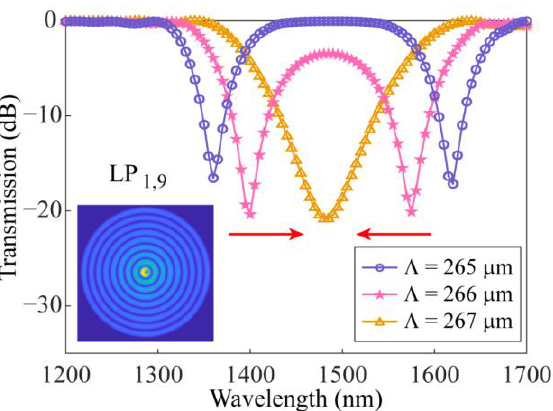
Figure 5. The simulated transmission spectra of the SMF-HLPGs with different grating periods.